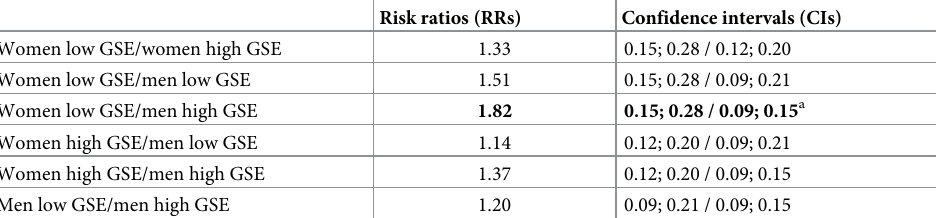
Table 3. Risk ratios (RRs) and confidence intervals (CIs) for frequent pain at follow-up, associated with baseline general self-efficacy (GSE) among all possible combinations of GSE and sex. Risk ratios (RRs) Confidence intervals